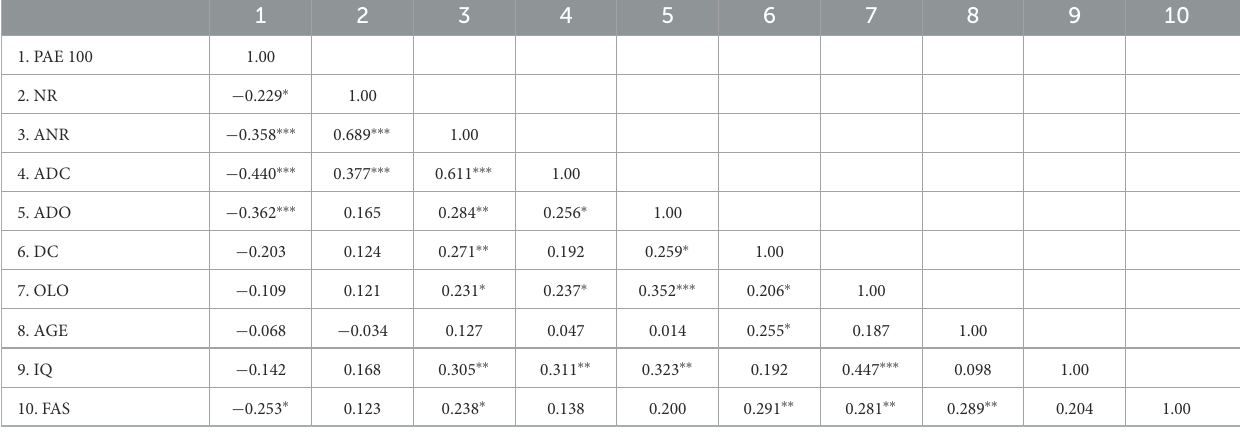
TABLE 2 Pearson’s correlation between all variables, ( N =